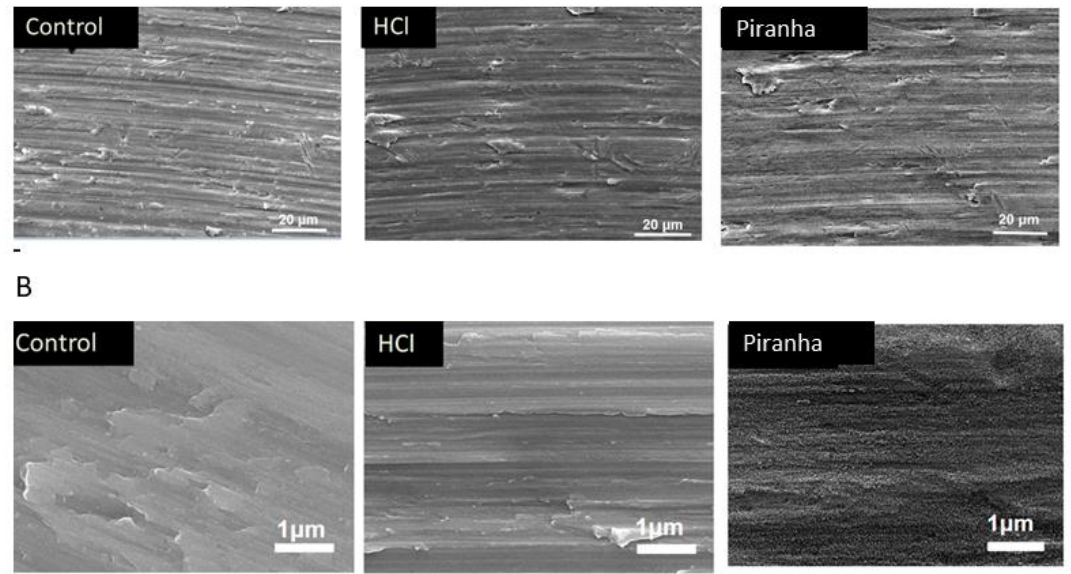
Figure 3. ( A ) Surfaces of grade 5 Ti alloy treated with different passivation methods; ( B ) at higher magnifications.